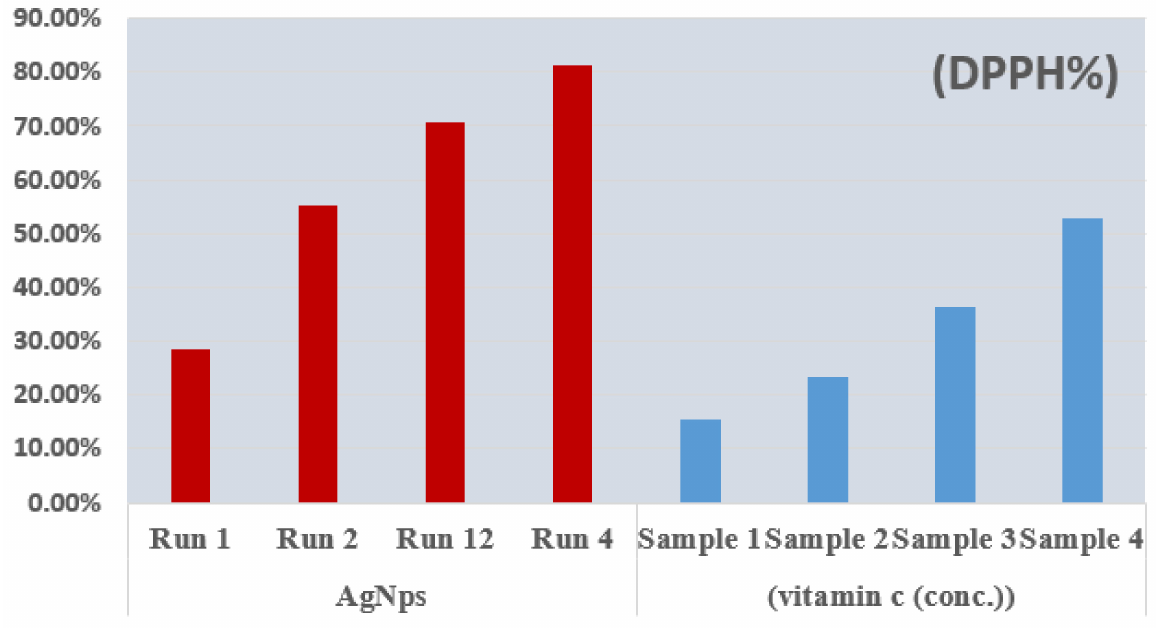
Figure 13. DPPH scavenging activity of optimized AgNPs, with different concentrations of vitamin C for